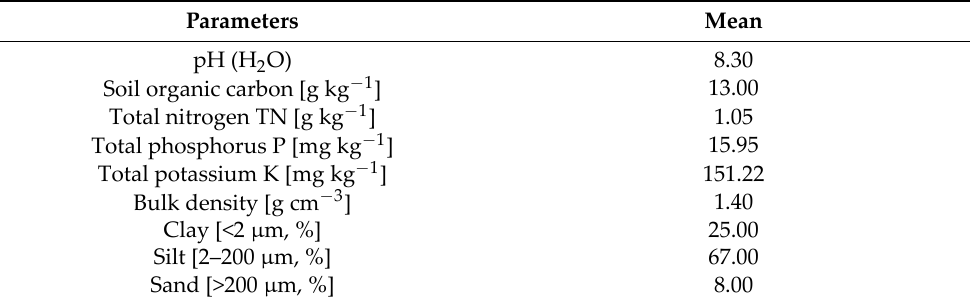
Figure 1. Geographical location map and experimental site. Table 1. Physicochemical properties of the soils in the experimental plots (0–20 cm layer).